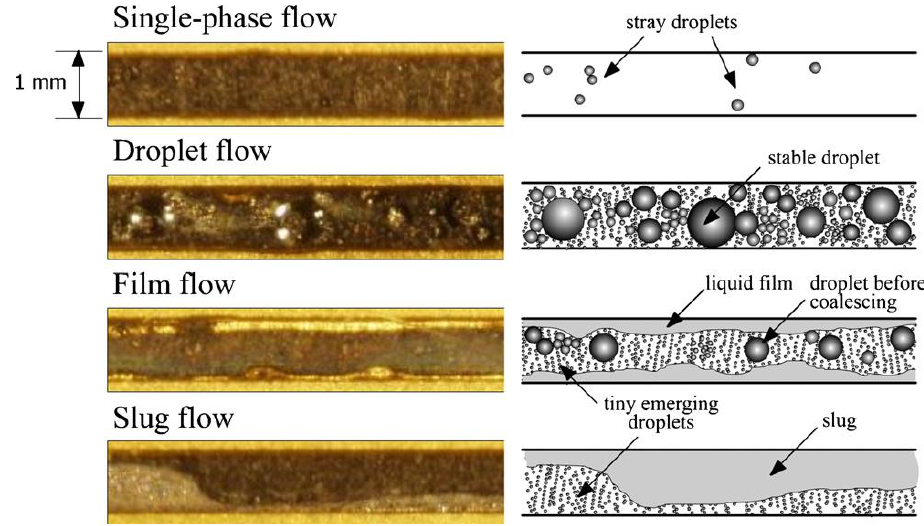
Figure 6. Magnified view of flow patterns in channels and their corresponding line illustrations showing the form and distribution of liquid water